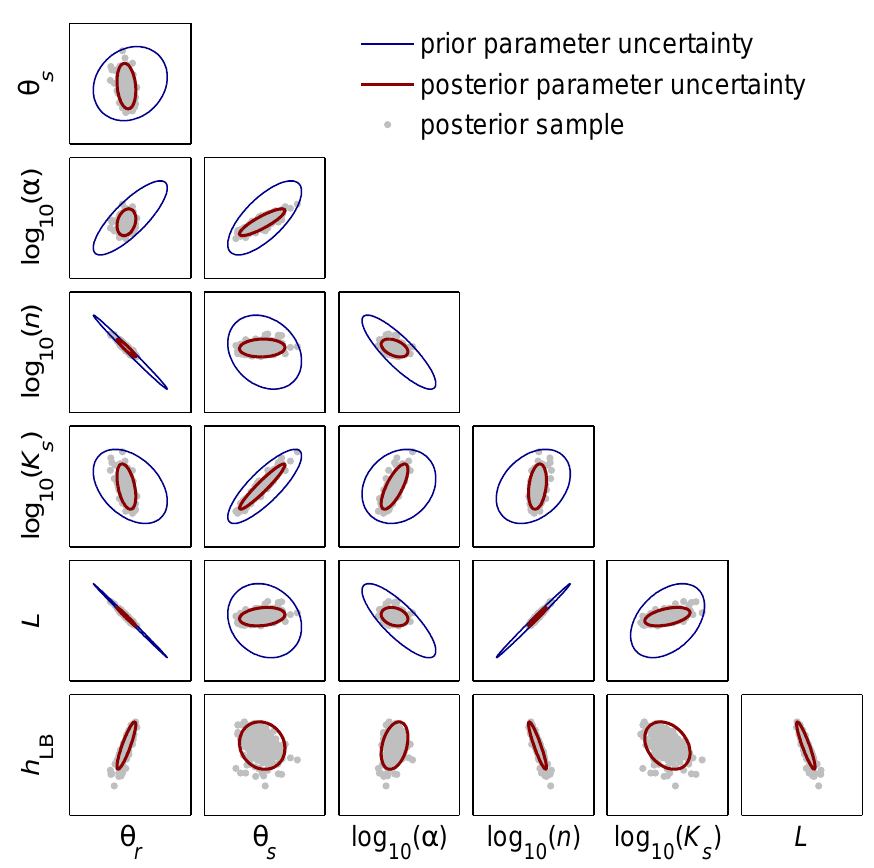
Fig. 7. Pairwise scatter plots of the posterior sample and corresponding 95% confidence ellipses using real soil water content data and the prior probability distribution with correlation among the soil hydraulic parameters (Prior 3). The axes cover the bounds listed in Table 1.